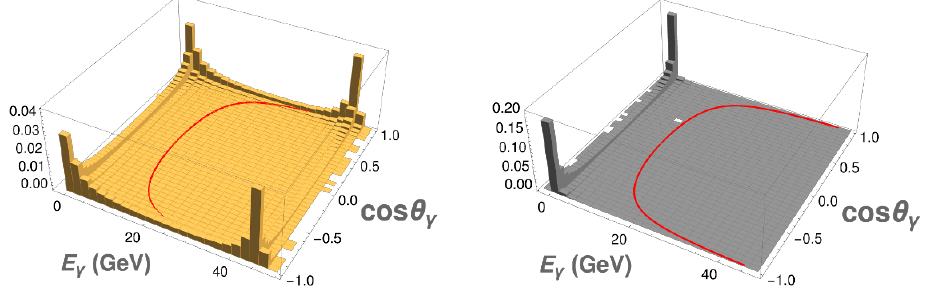
Figure 8 . Normalized E (cid:13) distribution in the Z -mode (left) and in the WW -mode (right), for both the e + e (cid:0) ! (cid:31) (cid:22) (cid:31)(cid:13) processes in millicharged DM models and the e + e (cid:0) ! (cid:23) (cid:22) (cid:23)(cid:13) processes in SM. Events in 50 bins on both plots are computed with detector cuts: E (cid:13) > 0 : 1 and j cos (cid:18) (cid:13) j < 0 : 99. For the millicharged models, we consider " = 0 : 01 for three di(cid:11)erent masses in each case; we consider m (cid:31) = 1 GeV, 25 GeV, and 40 GeV in the Z -mode, and m (cid:31) = 1 GeV, 25 GeV, and 50 GeV in the WW -mode.